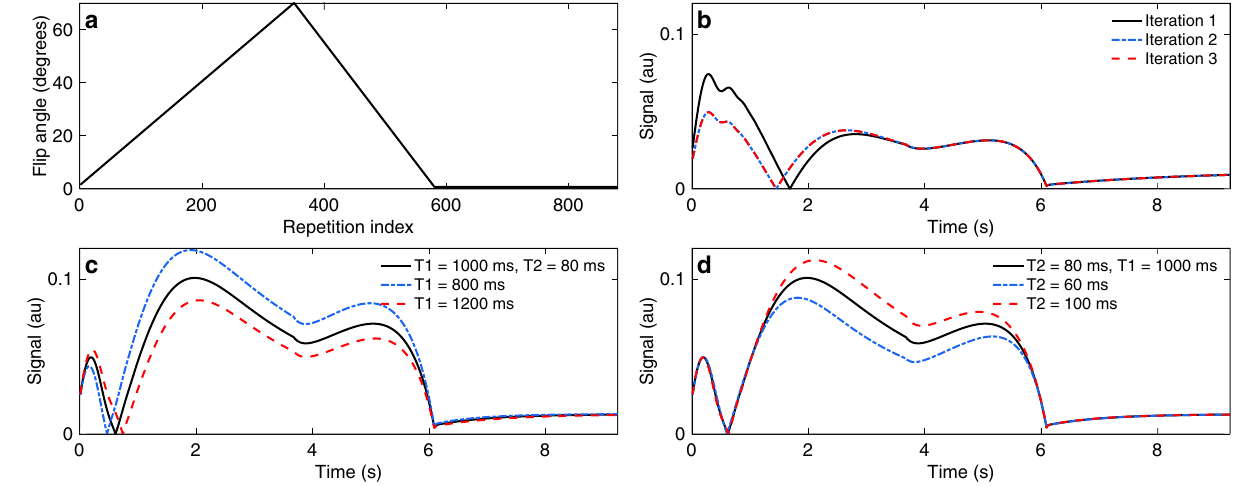
Figure 1. Excitation pattern. ( a ) The excitation pattern consists of a flip angle ramp to encode for T1 and T2 followed by constant, small flip angles to allow for T1 recovery before the next inversion pulse. ( b ) Signal evolutions reach a ‘steady’ transient-state after two iterations as magnetization before the inversion exhibits the same initial conditions after the first iteration. ( c , d ) T1 and T2 encoding: T1 is encoded into the signal through the inversion pulse prior to the flip angle train ( c ), whereas larger flip angle values produce spin echoes for T2 encoding ( d ).